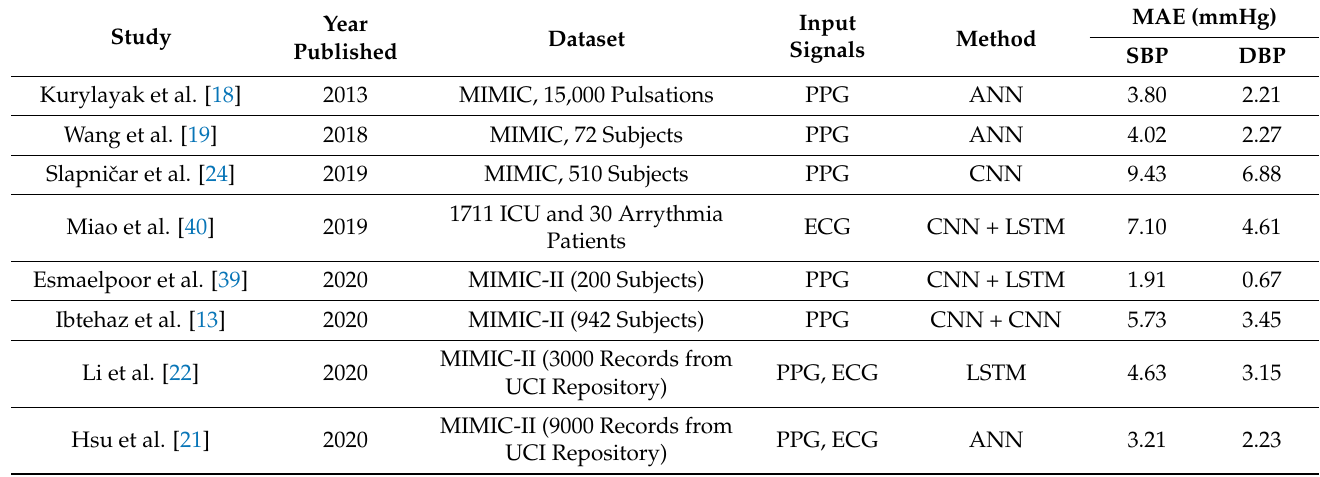
Table 11. Comparison of past studies based on MAE